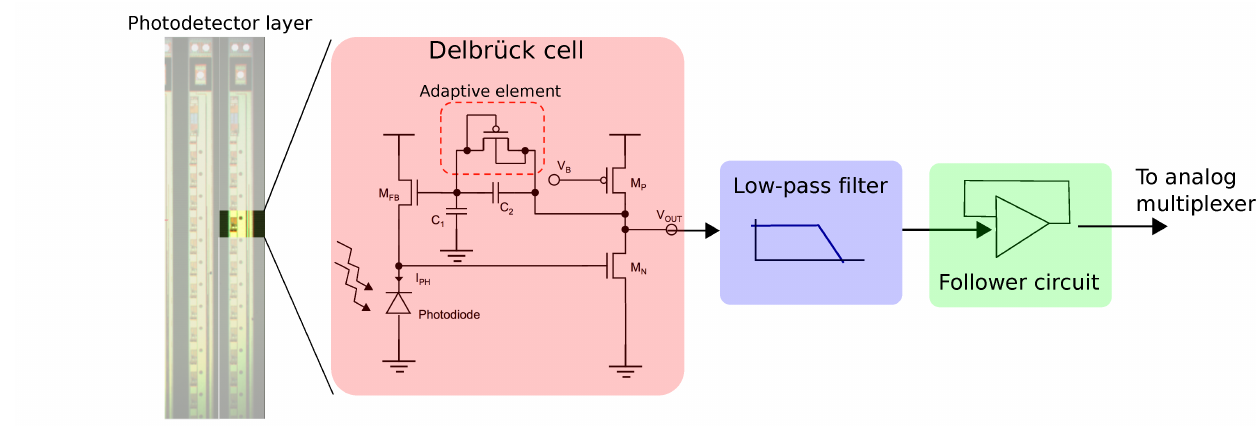
Figure 12. One of the 15 photodetector cell of one CurvACE column. The original circuit developed by Delbrück and Mead [27] was enhanced here by cascading a first-order low-pass filter to prevent temporal aliasing. Adapted from